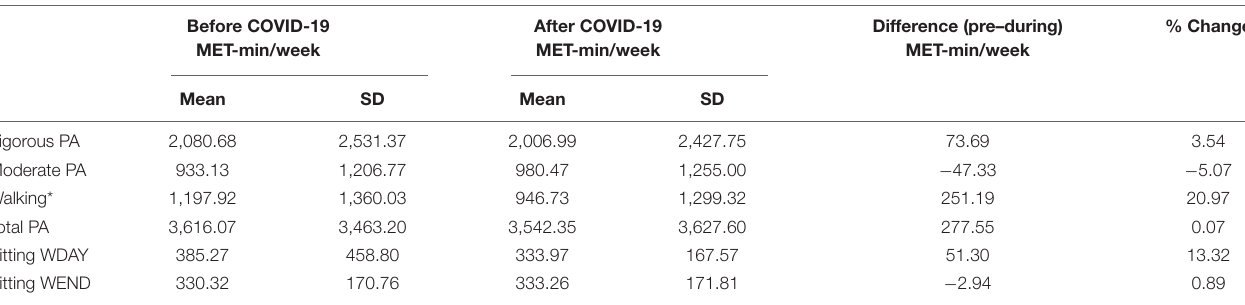
TABLE 2 | Physical activity and sedentary behaviors of male students before and during COVID-19. Before COVID-19 MET-min/week